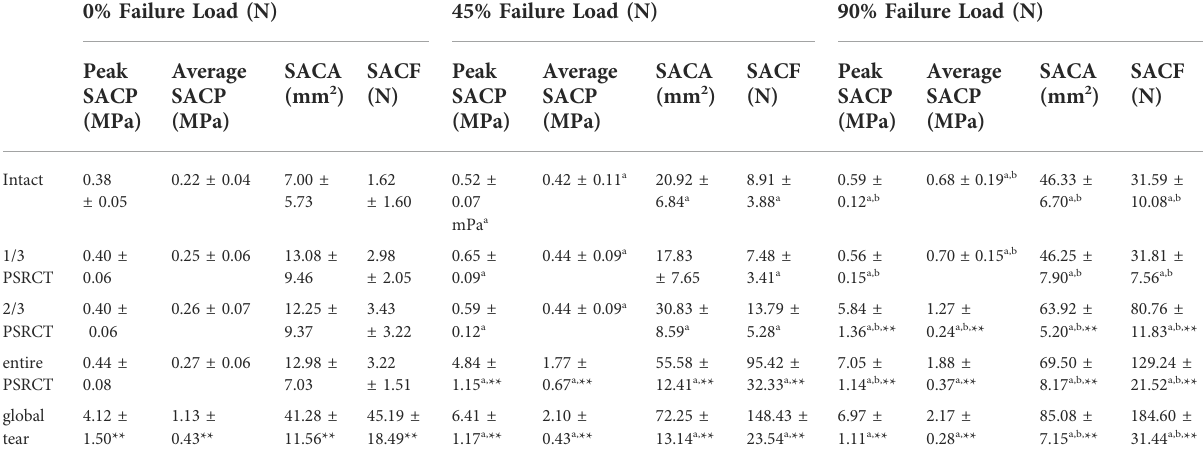
TABLE 2 Effect of RCT on the subacromial contact pressure, area, and force during